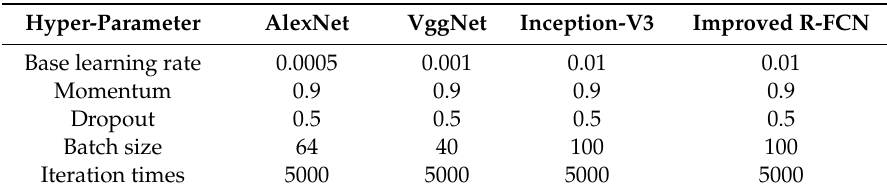
Table 3. Hyper-parameters for all